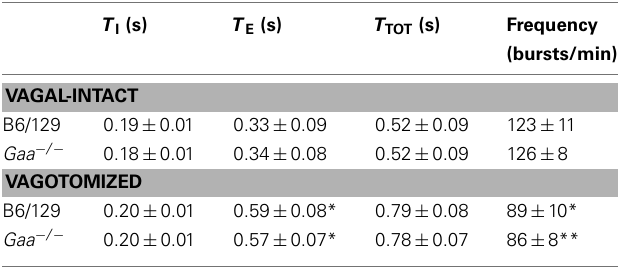
Table 1 | Respiratory cycle duration and frequency in B6/129 and Gaa − / −